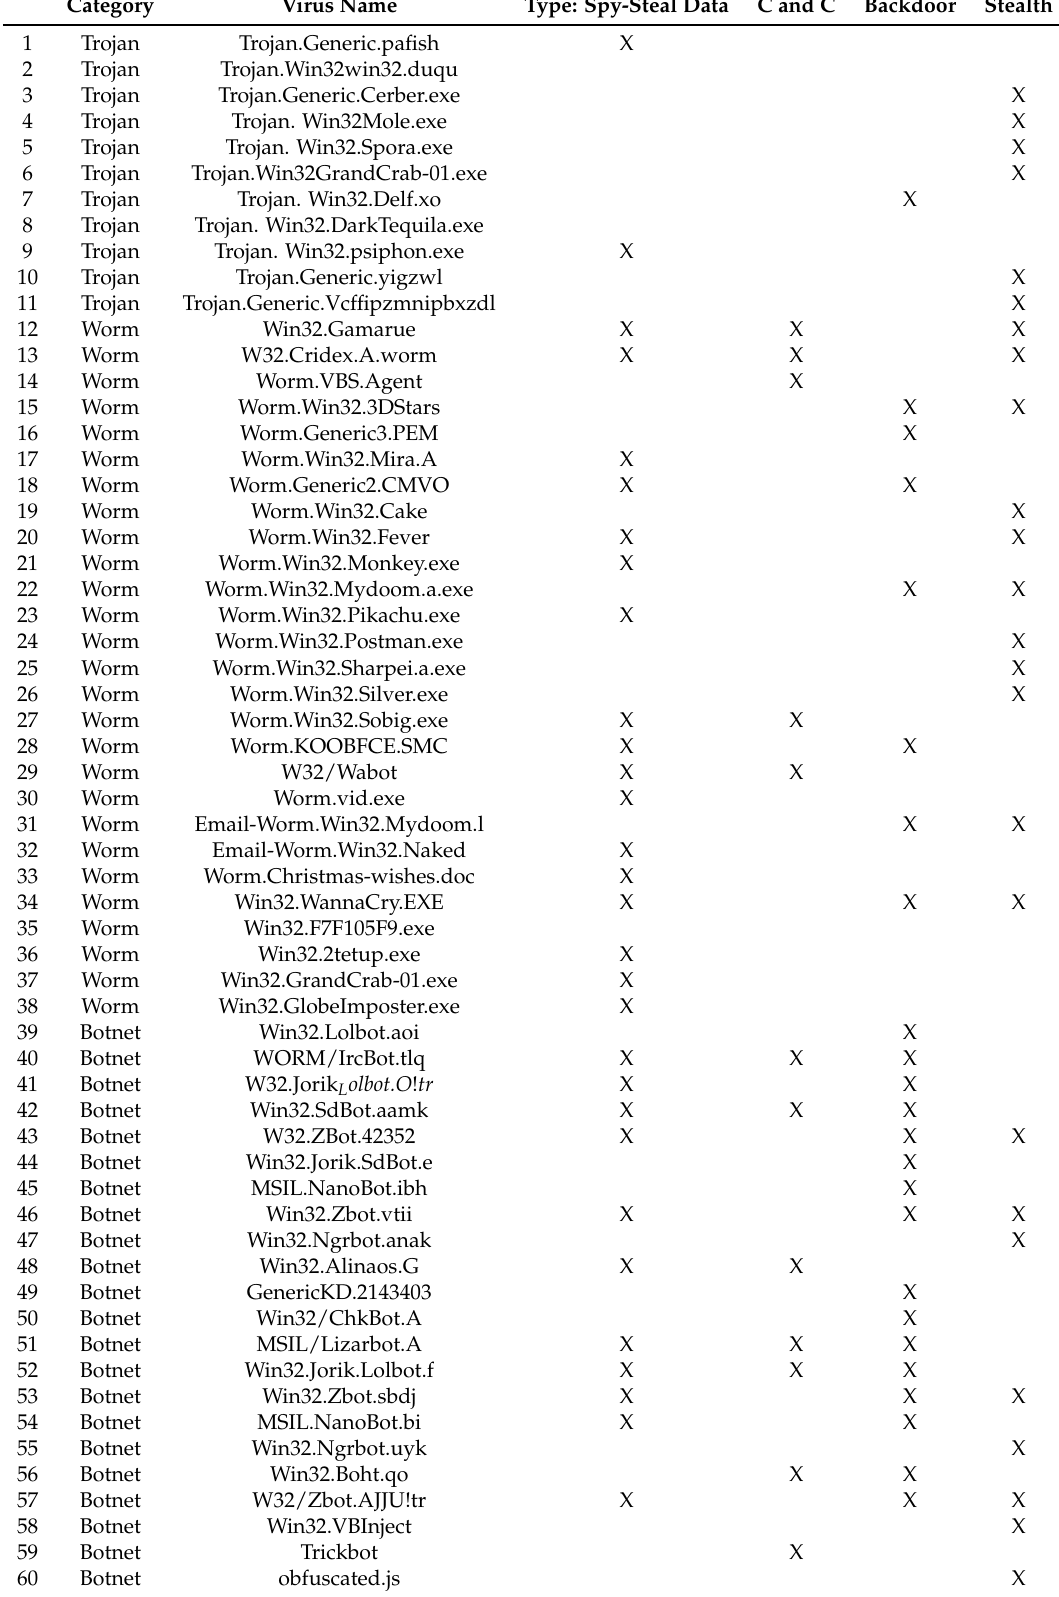
Table 5. Malware samples that were